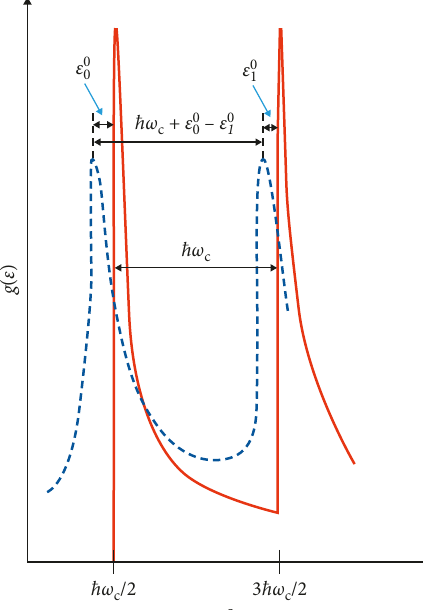
Figure 14: The density of electronic states of the zeroth and the first Landau levels in an ideal semiconductor (solid line) and in the presence of impurities (dashed line). ε 0 the zeroth and first Landau levels due to the SI fluctuation